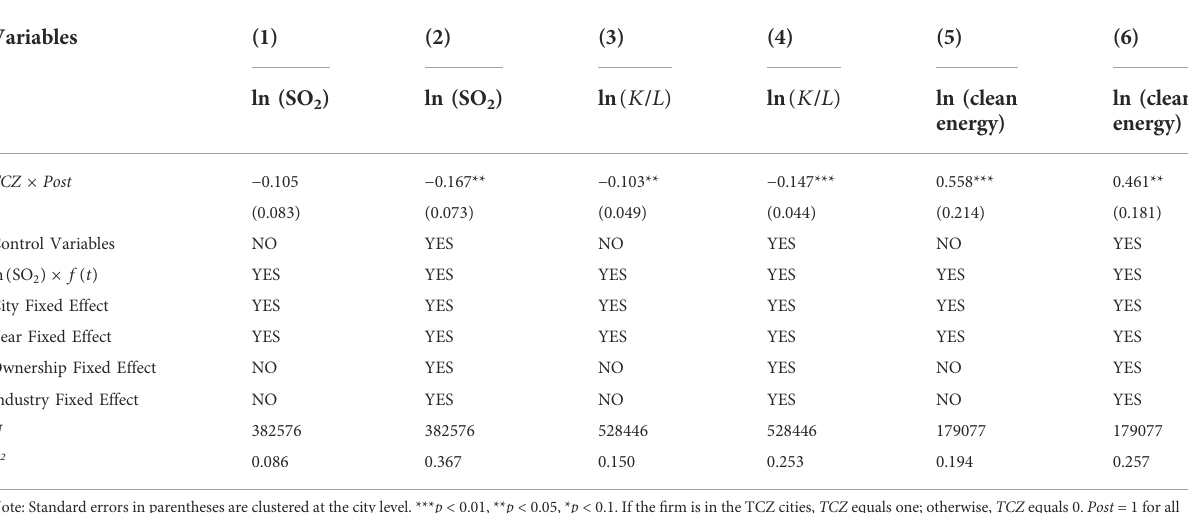
TABLE 4 Mechanism check: “ source control ”